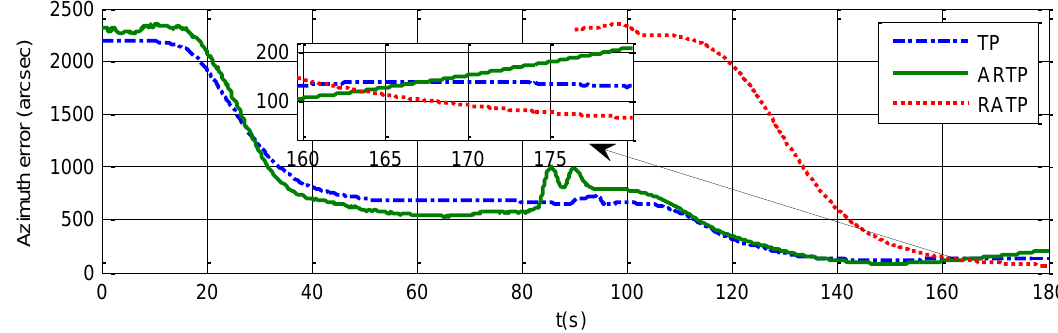
Figure 8. Azimuth error time history curve under angular vibrations with an amplitude of about 5 arcsec and a random frequency between 5 and 10 Hz when the total alignment time is 180